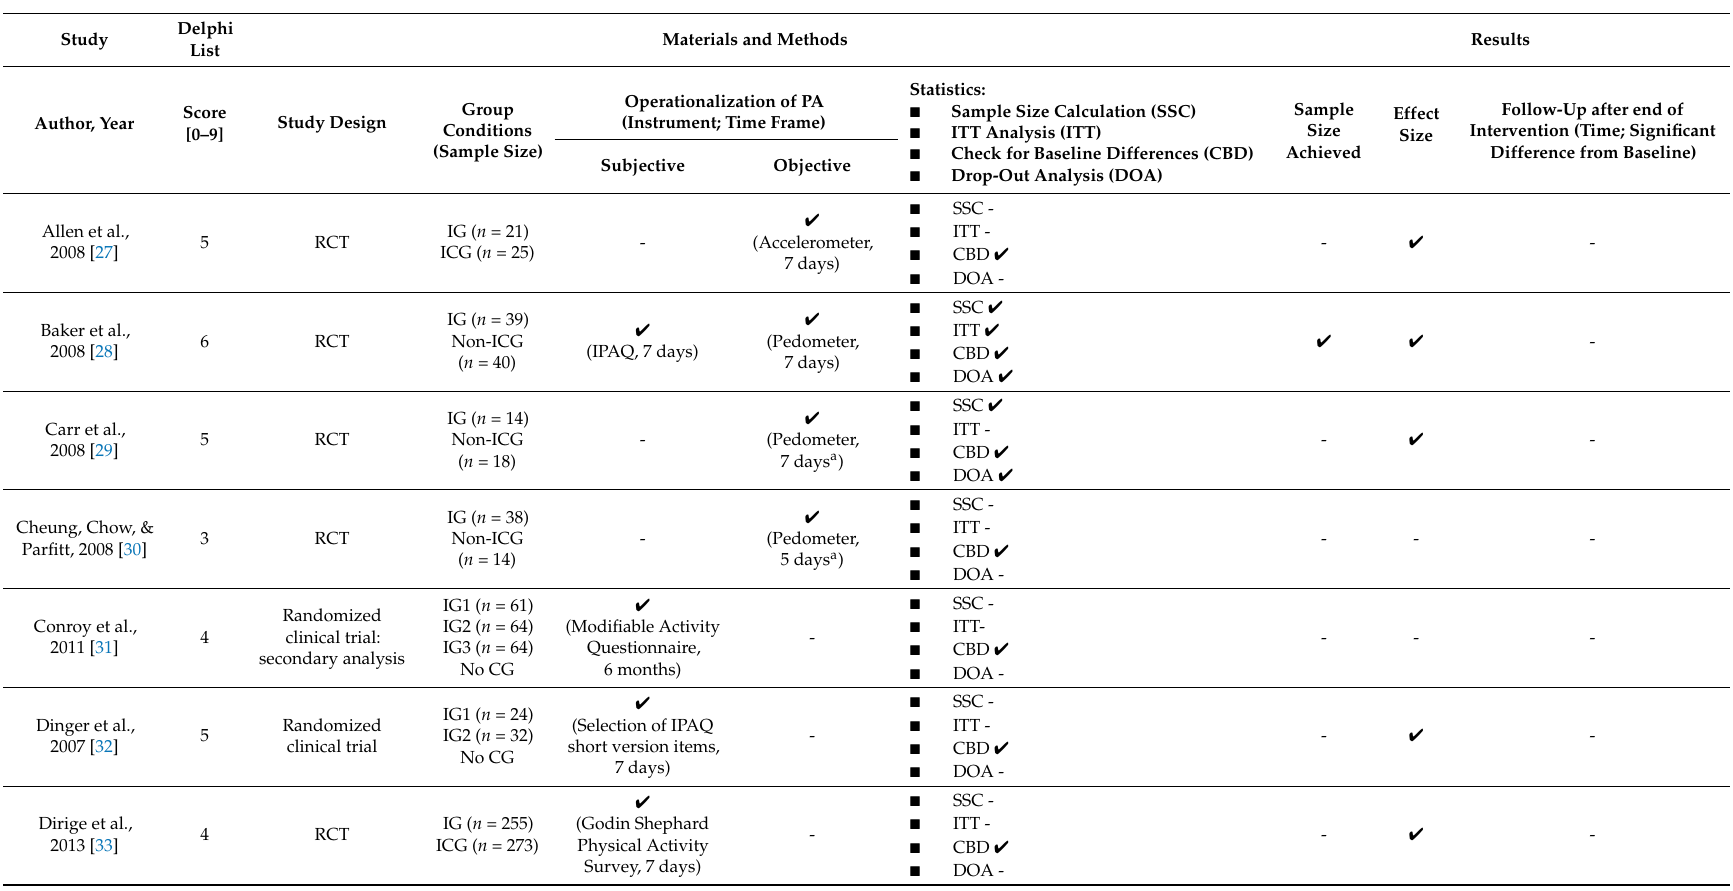
Table 2. Methodological components of effective PA